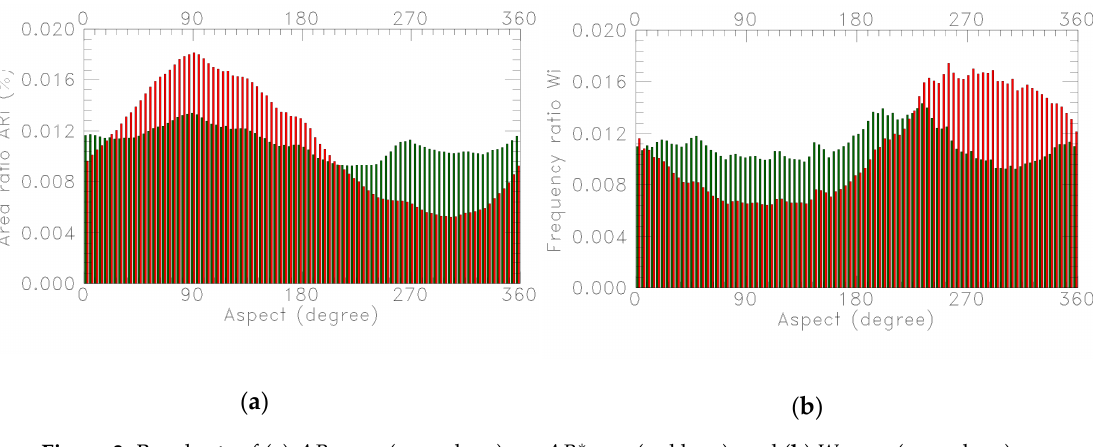
AR (green bars) vs. * Aspect